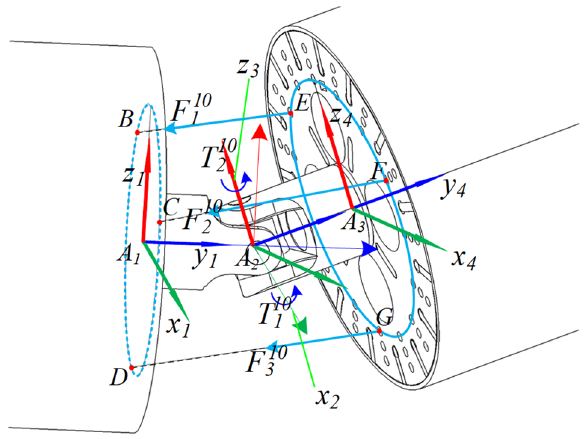
Figure 6. Force analysis of end joints in any posture.